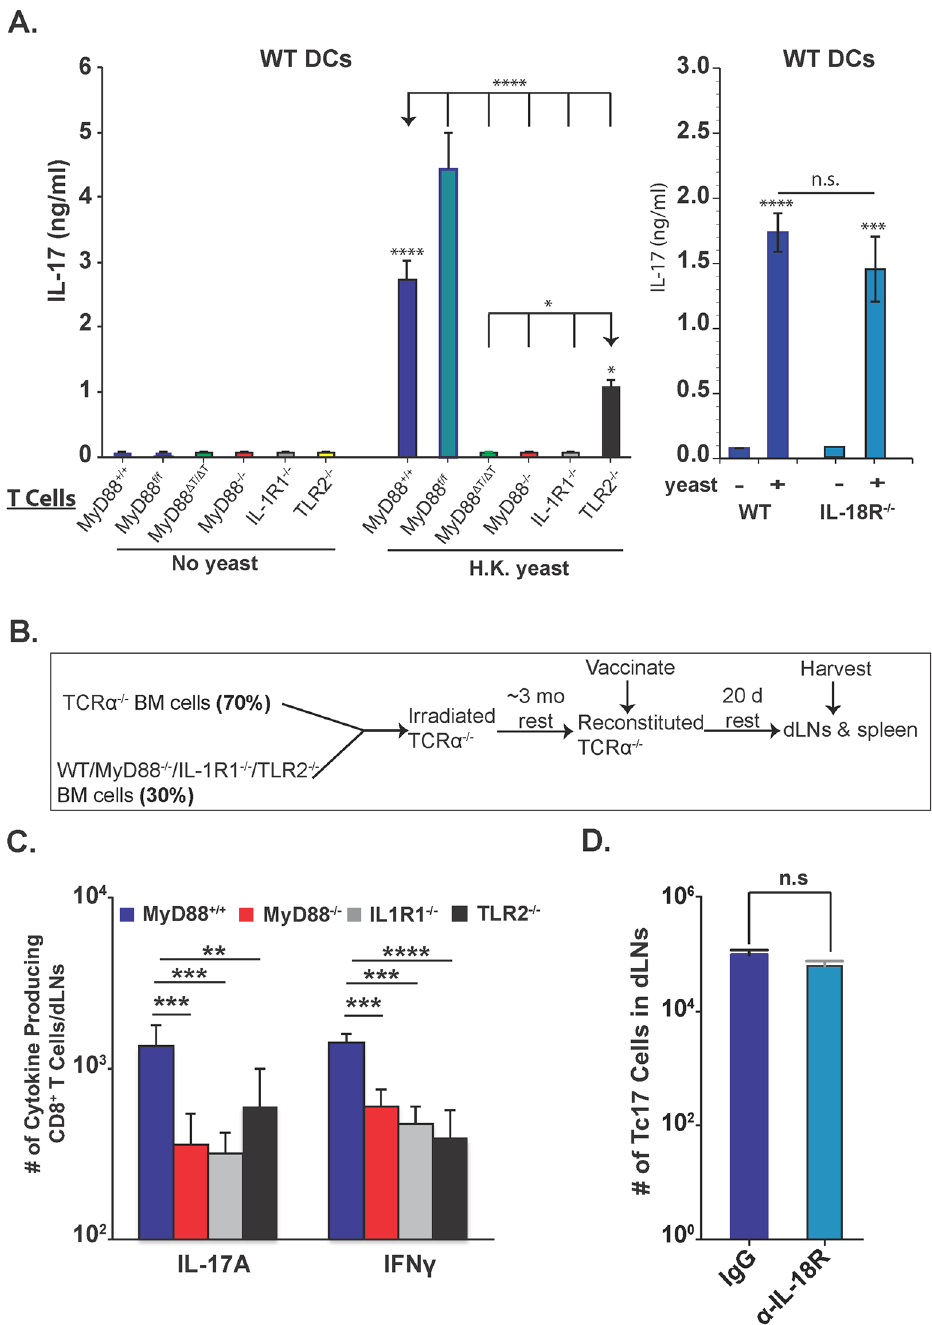
Fig 8. Role of IL-1R, IL-18R and TLR2 on Tc17 cell responses. A . Purified na ï ve CD8 + T cells were incubated with WT DCs either with or without heat-killed yeasts for 5 days. Culture supernatants were harvested to quantify IL-17A production by ELISA. Error bars are mean ± SD of triplicate wells. Data are representative of two independent experiments. B . Overview of the experimental approach for generation of bone-marrow chimera mice and harvesting of organs from vaccinated mice. C . Number of cytokine producing cells in dLNs 20 days post-vaccination. D . Number of cytokine-producing cells in the dLNs in either control IgG or anti-IL-18R blocking antibody-treated, vaccinated-mice groups on day 14. CD4 + T cells were depleted throughout the experiment. Error bars are mean ± SD of N = 4 – 7 mice/group. * p (cid:1) 0.05, ** p (cid:1) 0.01, *** p (cid:1) 0.001 and **** p (cid:1)